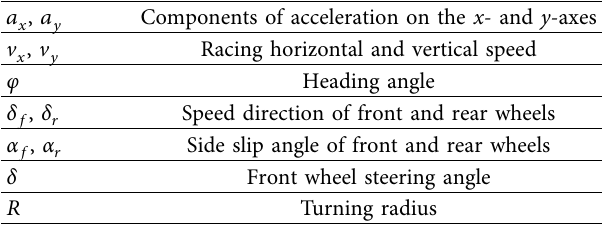
Table 2: Definition of symbols in the lateral tracking model of driverless racing car.